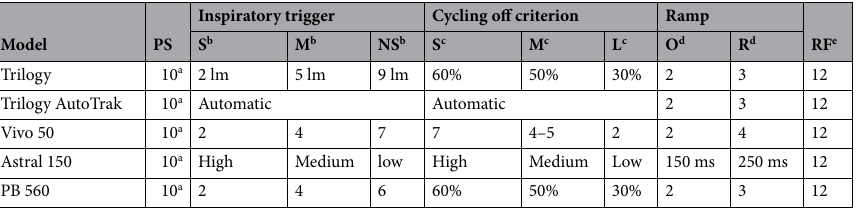
Table 1. Parameterization of the ventilators in the bench study model. Trigger setups for Astral, VIVO and PB 560 are indicated in an analogic scale. a IPAP: 15; EPAP: 5. b Inspiratory trigger: S: Sensitive; M: Moderately sensitive; NS: Not sensitive. c Cycling off criterion: S: Short; M: Medium; L: Long. d Pulmonary mechanics: O: Obstructive, R: Restrictive. e Respiratory frequency.